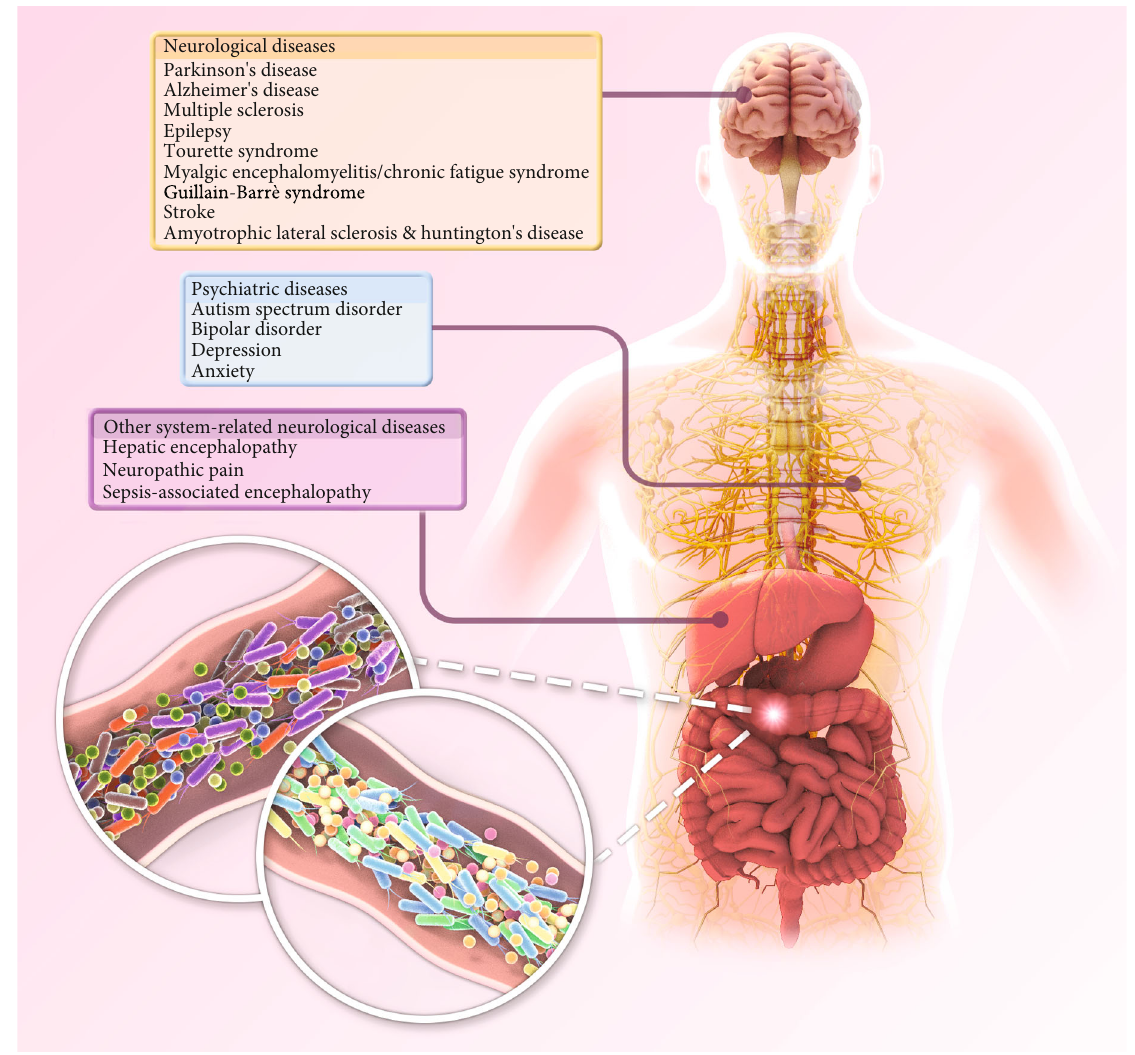
Figure 1: Current applications of FMT in various neurological and psychiatric diseases. Normal gut microbiota plays an important role in maintaining the functional stability of the gut-brain axis. Excessive reproduction of pathogenic bacteria or reduction of probiotics can lead to gut microbiota disorder and mediate a variety of neurological and psychological diseases. As an important therapeutic method to reconstruct gut microbiota, FMT has been tried to be applied to a variety of diseases related to gut-brain